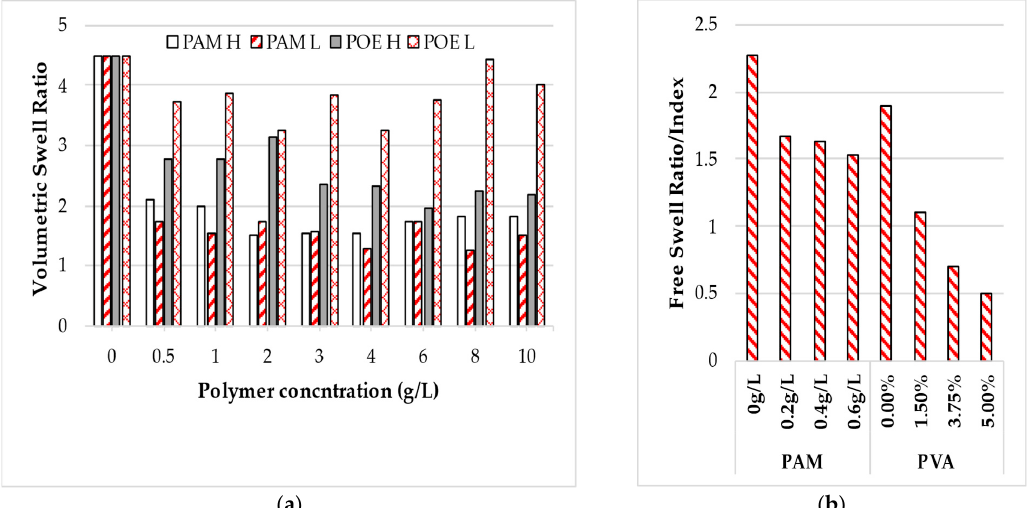
Figure 10. Variation in the sediment behavior of expansive clay with polymer concentration: ( a ) Volumetric swell ratio; ( b ) Free swell ratio/index (concentration of PVA as a % of dry weight of soil). Note: these figures were created with data obtained from [101,102,122].